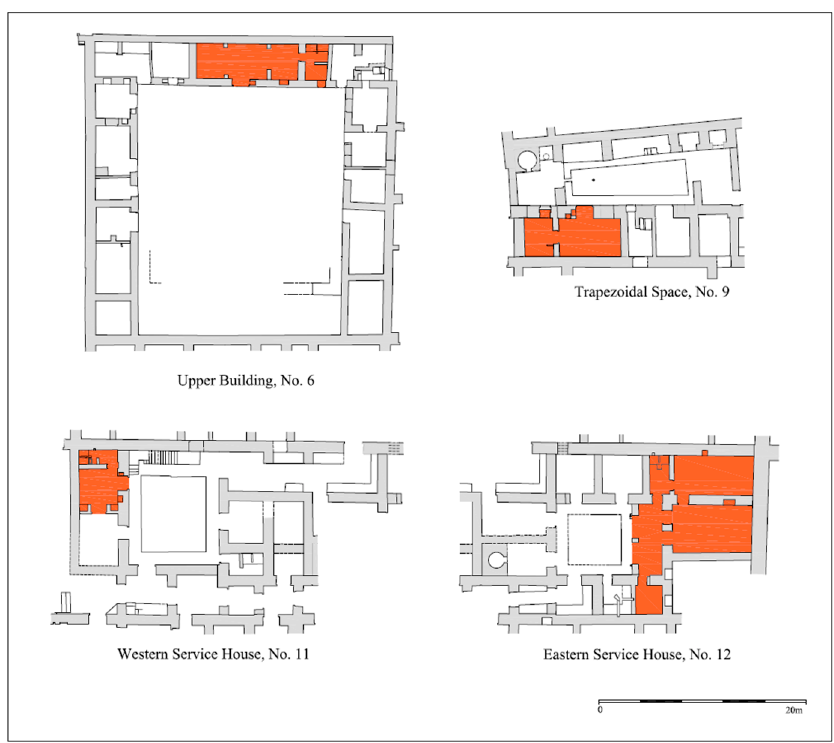
Figure 14. Hierarchical structure inside the residences (Nos. 6, 9, 11, and 12). Own elaboration on the plan of Vallejo Triano (2010, Figures 9 and 56).